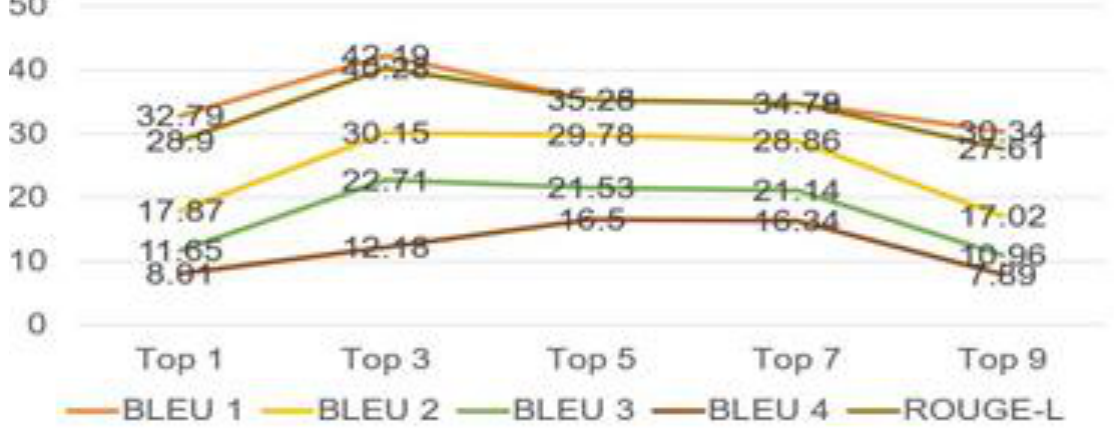
Figure 3. The impact of the number of ranked triples encoded on the Multi-encQG++ model perfor- mance in WebQA dataset.